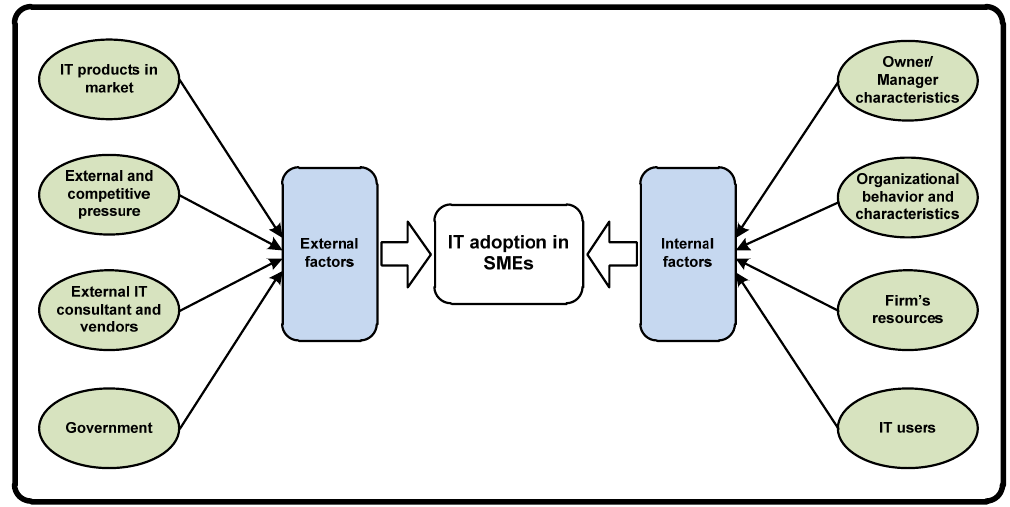
Figure 1. Proposed framework of IT adoption influencing factors in SME